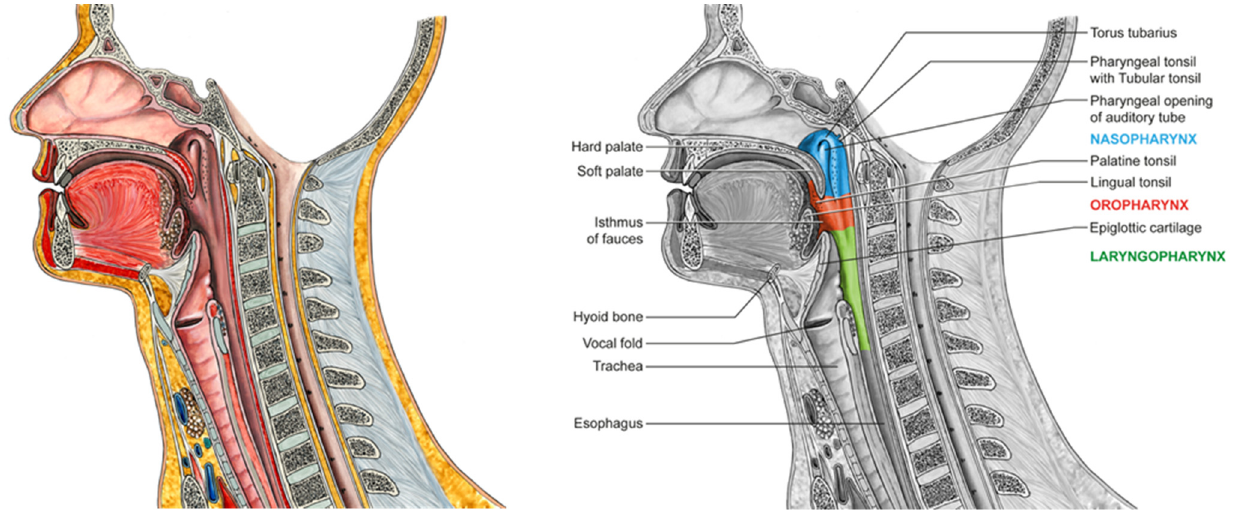
Figure 2. The upper respiratory tract with the naso- and oropharynx in the sagittal plane. This figure shows the division into nasal, oral and laryngeal parts of the human body. The pharynx is connected to the nasal cavity through the choanae, to the middle ear through the auditory tubes, to the oral cavity via the isthmus faucium and to the larynx via the aditus larynges [30] . This illustration was created by Jörg Pekarsky, illustrator at the Institute of Functional and Clinical Anatomy, FAU Erlangen-Nürnberg, Erlangen, Germany.